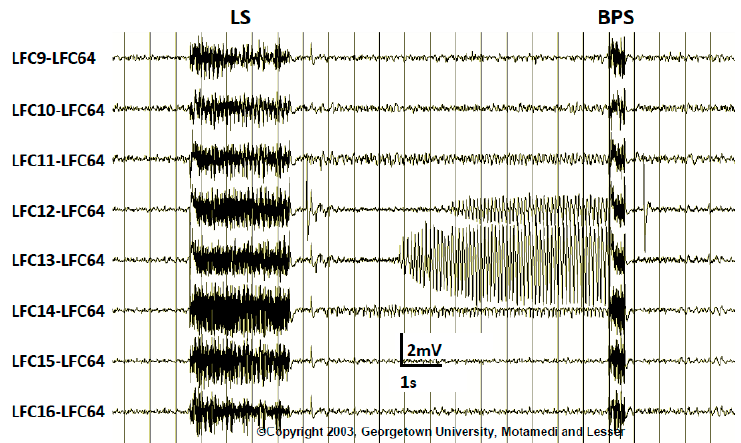
Figure 7. During stimulation mapping the pulse stimulus (LS, localization stimulus) may induce afterdischarges (AD). In some cases, a brief pulse stimulus (BPS) may successfully terminate the AD and prevent a clinical seizure.